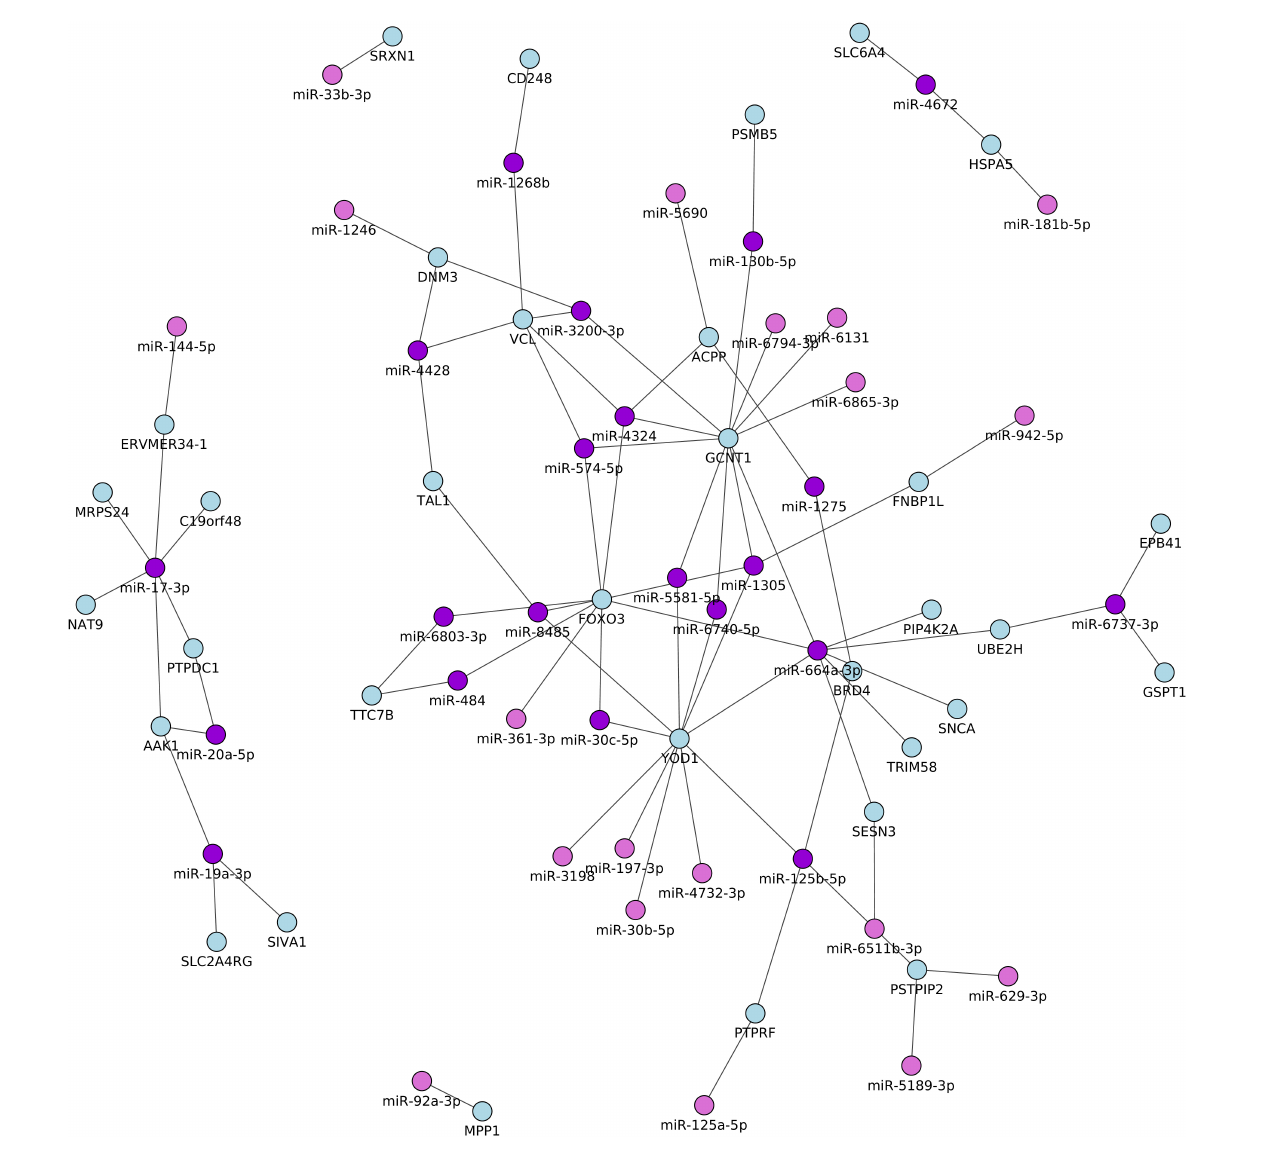
FIGURE3 Network of the differentially expressed miRNA and their potential target mRNAs with inverse correlations between TGA patients and controls. Only pairs with a correlation coefficient of ≥ –0.5, P < 0.05, and a miRNA binding site within the 3’UTR of the target